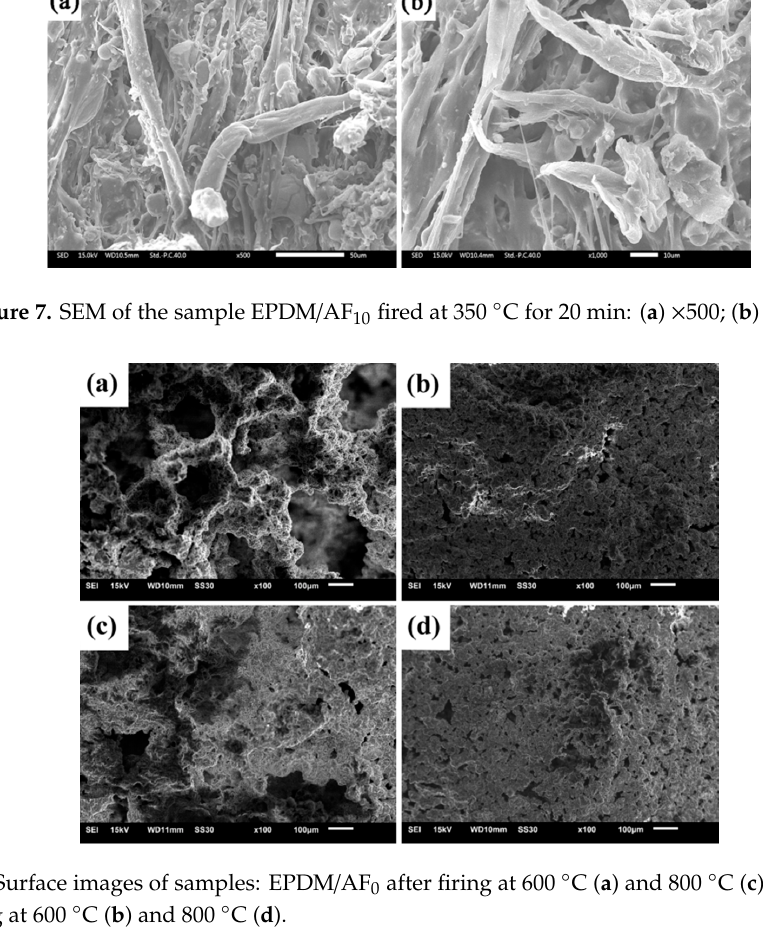
Polymers 2020 , 12 , x FOR PEER REVIEW 11 of 17